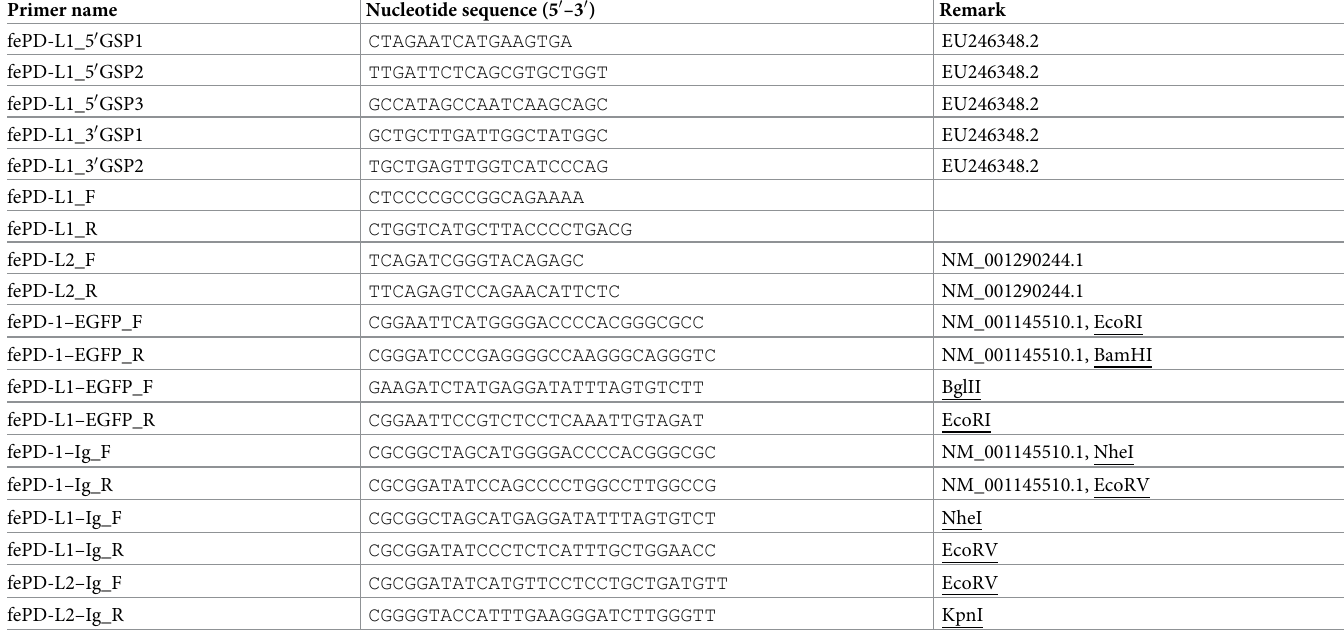
Table 1. PCR primer